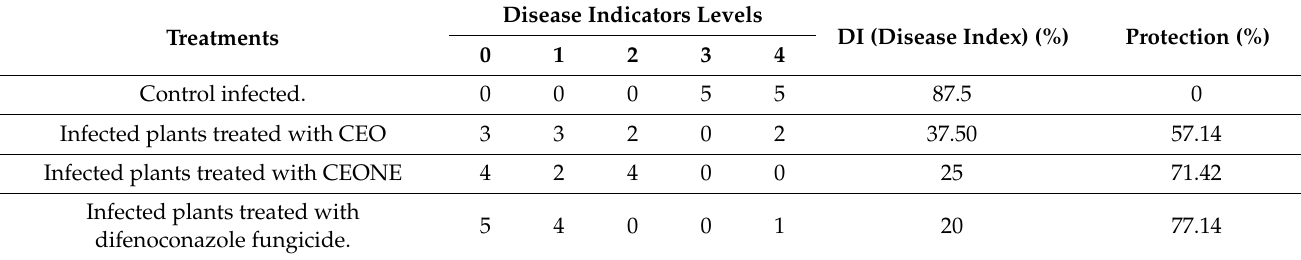
Table 1. Protection of CEO and CEONE and difenoconazole against N. dimidiatum . Disease Indicators Levels DI (Disease Index) (%) Protection (%) Treatments 0